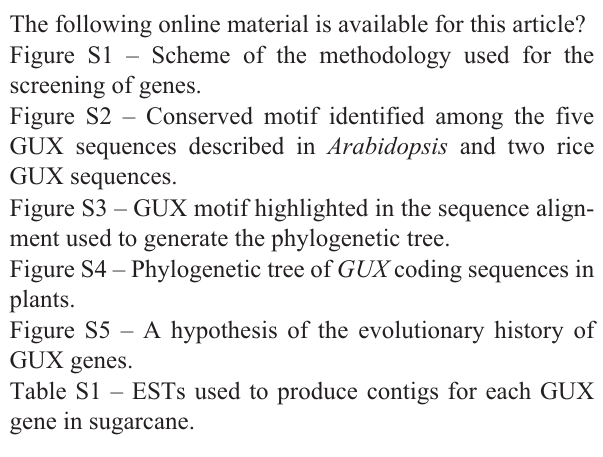
Figure S1 – Scheme of the methodology used for the screening of genes. Figure S2 – Conserved motif identified among the five GUX sequences described in Arabidopsis and two rice GUX sequences. Figure S3 – GUX motif highlighted in the sequence align- ment used to generate the phylogenetic tree. Figure S4 – Phylogenetic tree of GUX coding sequences in plants. Figure S5 – A hypothesis of the evolutionary history of GUX genes. Table S1 – ESTs used to produce contigs for each GUX gene in